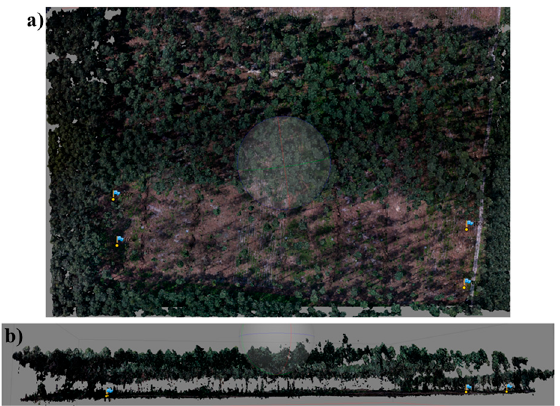
Figure 7. Illustration of different perspectives of the 3D model reconstruction of the study area in Photoscan: nadir (down-looking) camera ( a ) and side view ( b ).